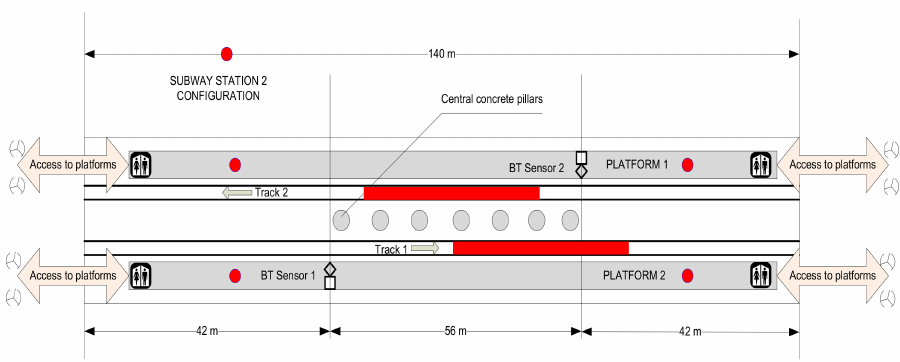
Figure 2. Aspect of Station 2 test bed setup (red dots represent placement of human